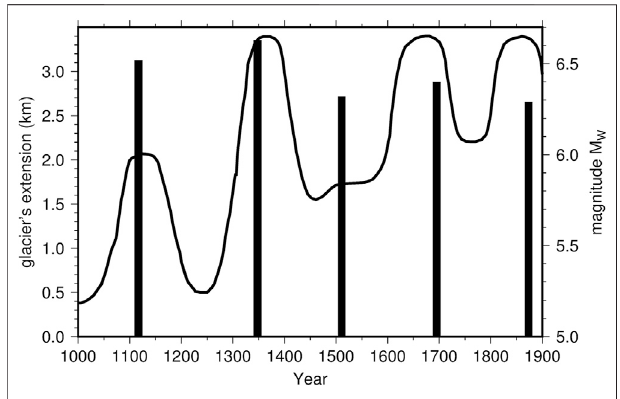
FIGURE 8 | Relationship between the occurrence of M ≥ 6.2 earthquakes in northeastern Italy (vertical bars) and the glacial evolution in the Swiss Alps between 1000 and 1900 AD (continuous